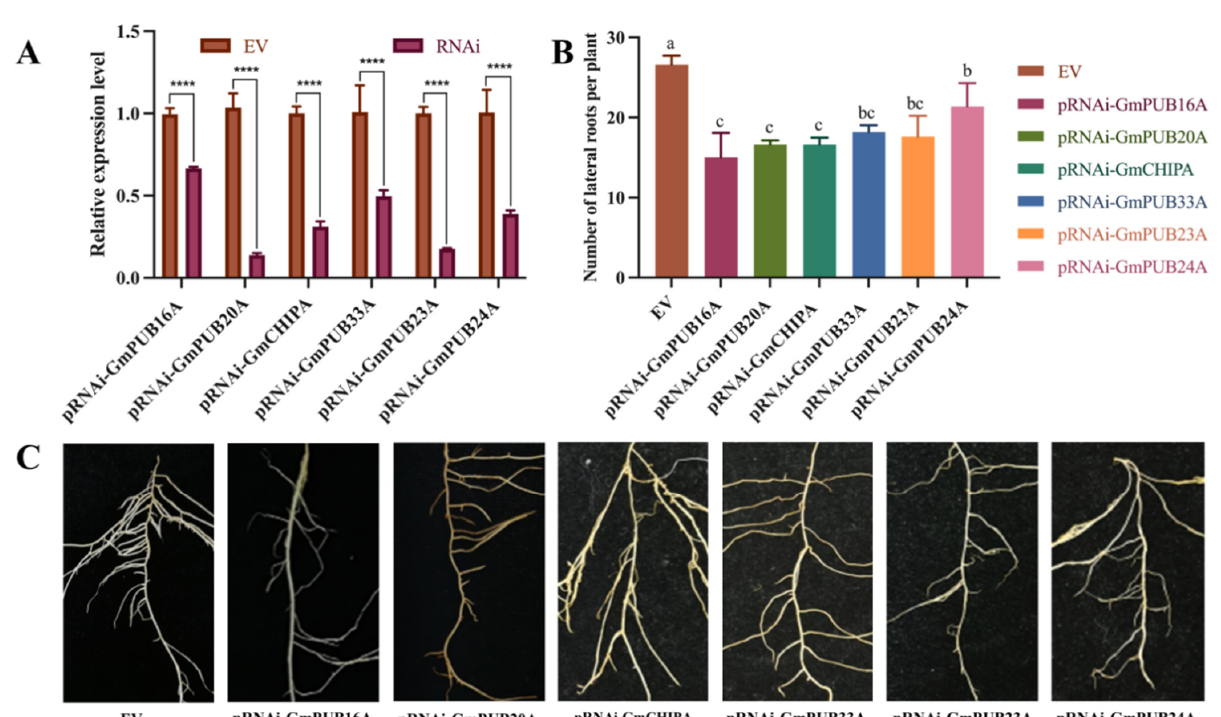
Figure 7. Expression profiles and biomass analysis of six GmPUBs in the RNAi hairy roots. Note: ( A ), The relative expression of six GmPUBs in the RNAi hairy roots, ( B ), Biomass analysis of GmPUBs RNAi hairy roots, ( C ), Lateral roots of GmPUBs RNAi hairy roots. One-way ANOVA was applied in SPSS to analyse the difference the number of lateral roots in EV and transgenic hairy roots. Multiple t -tests were applied to detect the significant differences of the relative expression level of all GmPUBs in EV and other transgenic hairy roots on Graphpad prism 9. ns represent not significant. **** indicate significant difference at the p < 0.0001 probability level. Different characters mean significant differences found at p < 0.05